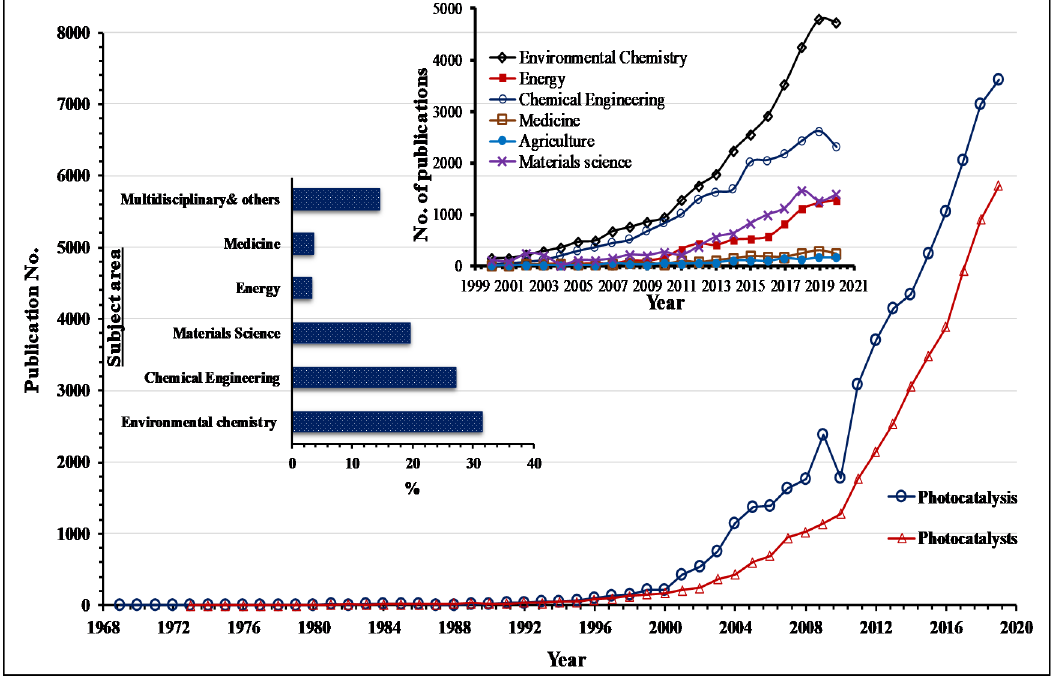
Figure 1. A meta-analysis of the Scopus research database for publications with “Photocatalysis” or “Photocatalyst” keywords between 1970 and August 2020 (inset: no. of publications per research area).